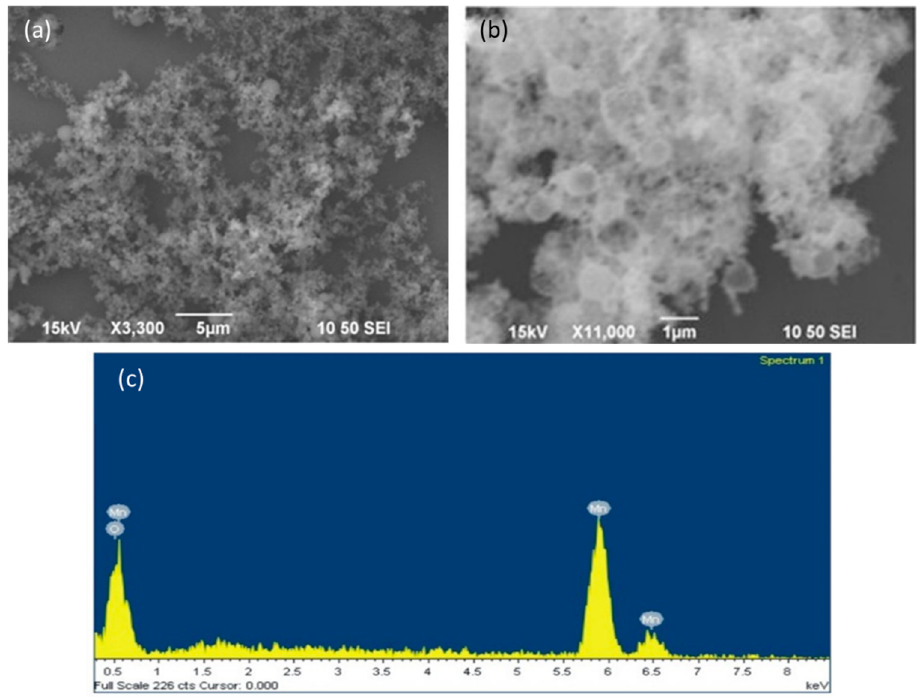
Figure 2. ( a ), ( b ) the SEM images of the MOHNs; ( c ) the EDS spectrum of MOHNs. Figure 2a is reproduced with permission from [16]. Copyright IEEE, 2016.